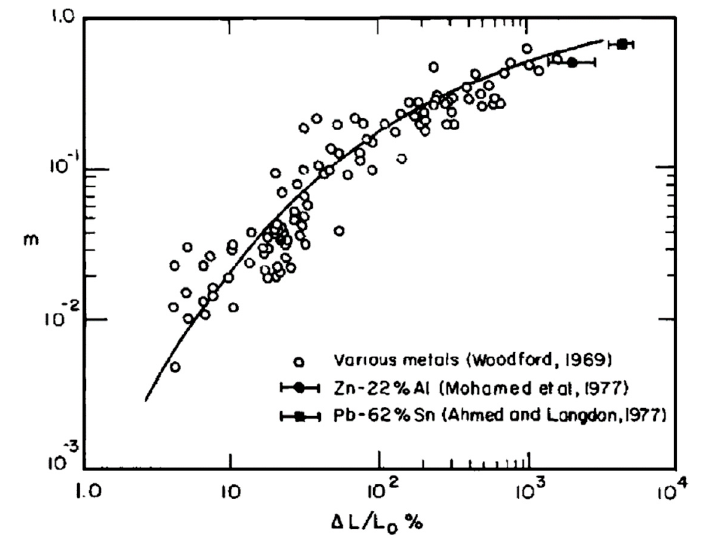
Figure 2. Strain rate sensitivity versus elongation to failure for various metals [7] including results for Zn–22% Al alloy [8] and Pb–62% Sn alloy [9].